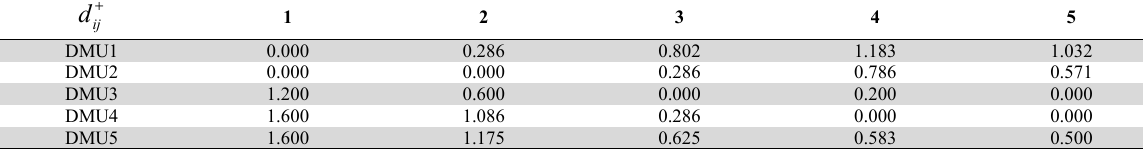
The distance from PIS for alternative i and criterion j for a performance assessment problem d + 1 2 ij